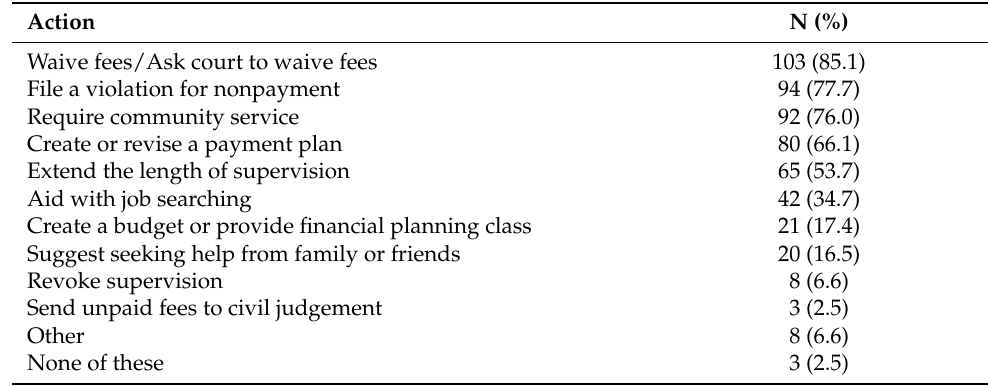
Table 3. Reported actions taken by respondents or agencies in cases of nonpayment of fees (N = 121).